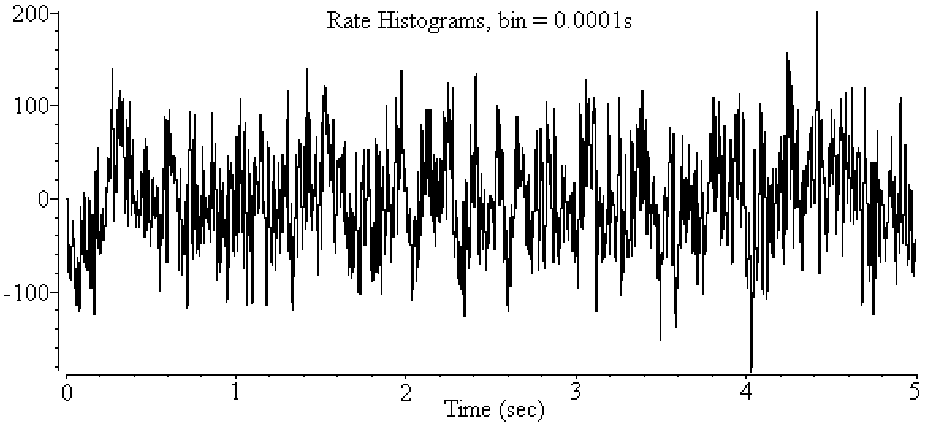
Figure 1. Electroencephalogram (EEG) signal.